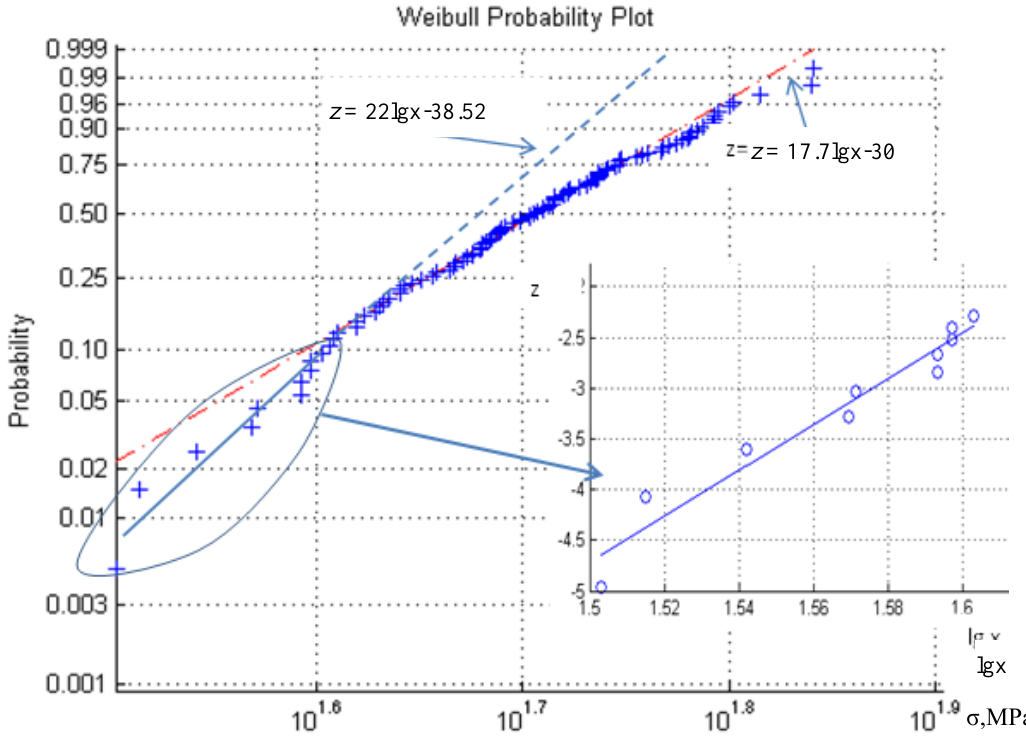
Fig.5 Bi-modal Weibull approximation of the experimental bending tests